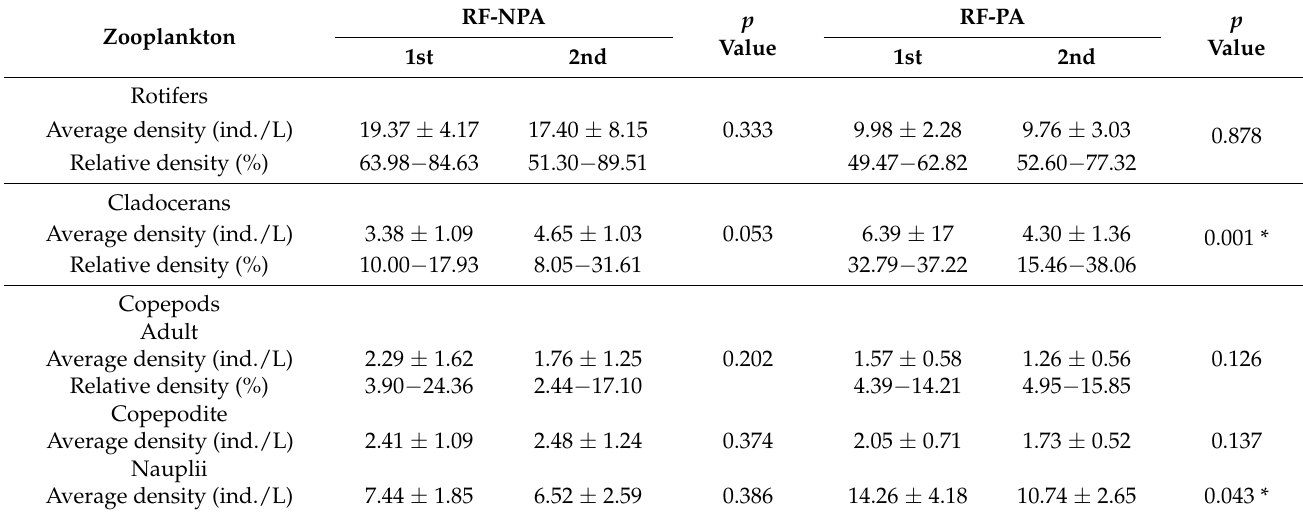
Average density